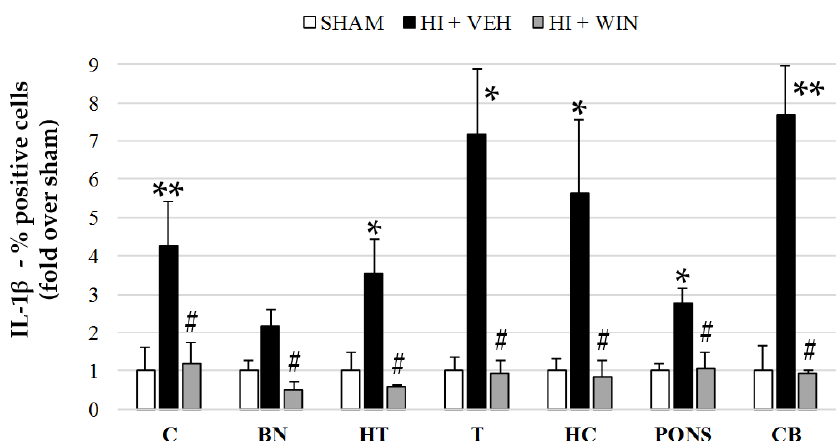
Figure 5. Evaluation of IL-1β expression in different brain regions evaluated after sham or HI (and vehicle or WIN treatment) in fetal lambs. Samples from both hemispheres were analyzed in triplicate by flow cytometry ( n = 6) for each animal and condition. Values given as the mean ± SD of the percentage of IL-1β positive cells. (*) ANOVA p < 0.05 vs. sham and HI+WIN; (**) ANOVA p < 0.01 vs. sham and HI+ WIN; (#) ANOVA p < 0.05 vs. HI+VEH. Sham, n = 6; HI + VEH, n =6; HI+WIN, n = 6. (C: cortex; BN: basal nuclei; HT: hypothalamus; T: thalamus; HC: hippocampus; CB: cerebellum).